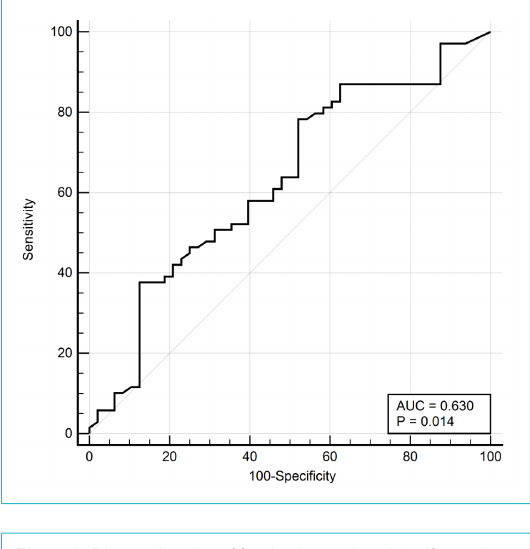
Figure 2: Overall diagnostic value of fecal calprotectin to identify small bowel findings. Receiver operating characteristics (ROC) with area under the curve (AUC).